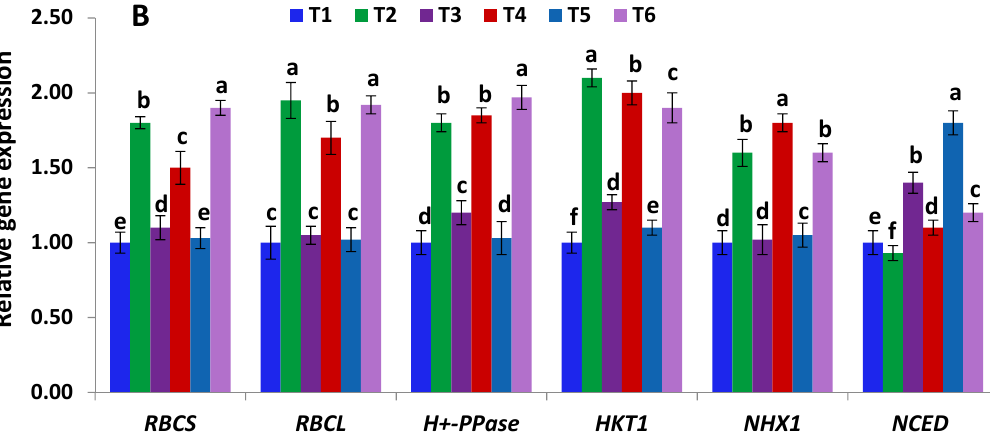
Figure 2. Expression levels of antioxidant genes ( A ) and stress-related genes ( B ) of maize in absence and presence of Serratia liquefaciens KM4 under different saline concentrations. Data are means ± SE ( n = 5). Different letters indicate significant differences among treatments ( p ≤ 0.05). T1, non-inoculated control plants; T2, Serratia liquefaciens KM4-inoculated plants; T3, 80 mM NaCl-treated plants; T4, plants primed with 80 mM NaCl and Serratia liquefaciens KM4; T5, 160 mM NaCl-treated plants;